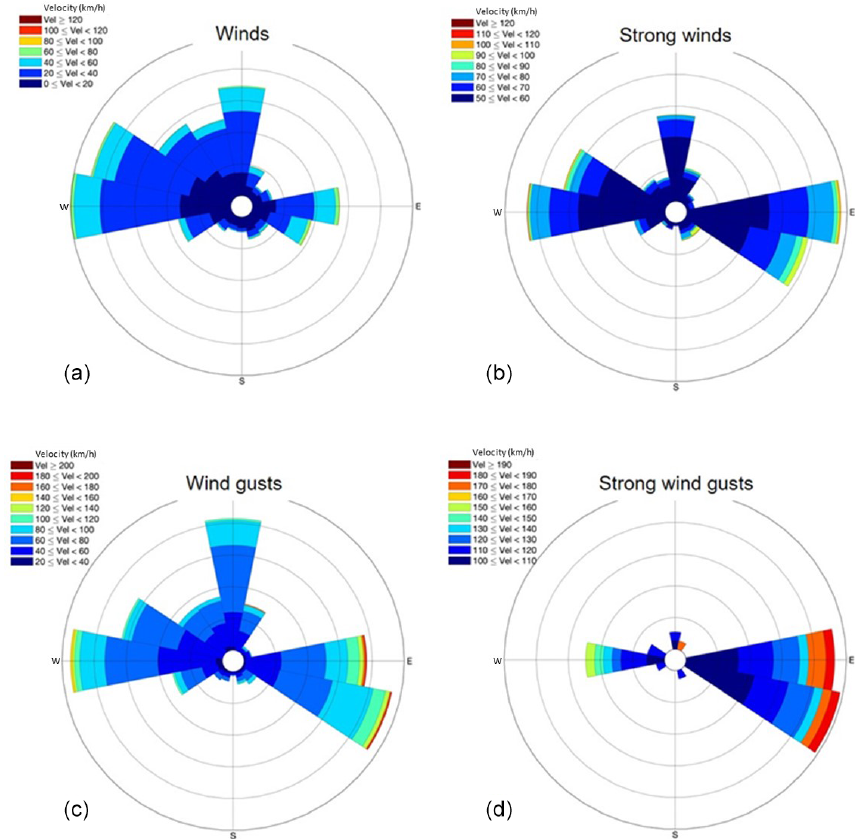
Figure 4. Wind roses obtained for the area of Artigas Scientific Antarctic Base based on historical data of the Uruguayan National Institute of Meteorology (January 1998–May 2016; 24698 records). The data are available for research through https://www.inumet.gub.uy/ (last access: 15 December 2017) with previous authorization from the institution. Based on the speed of winds considered, (a) and (b) refer